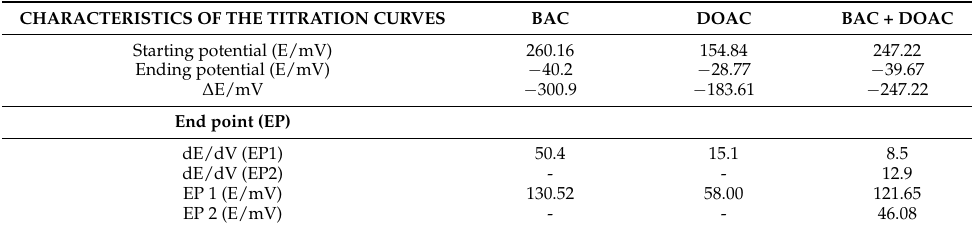
Table 5. Characteristics of titration curves of model solutions of BAC, DOAC, and the two-component model mixtures of BAC and DOAC (1:1 w / w ).